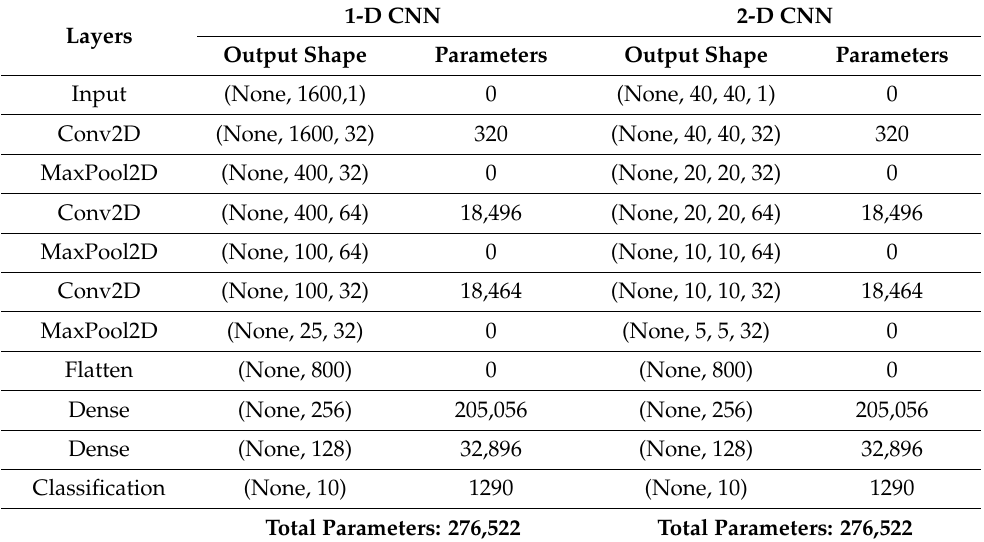
Figure 6. Architecture of proposed 1-D CNN model.